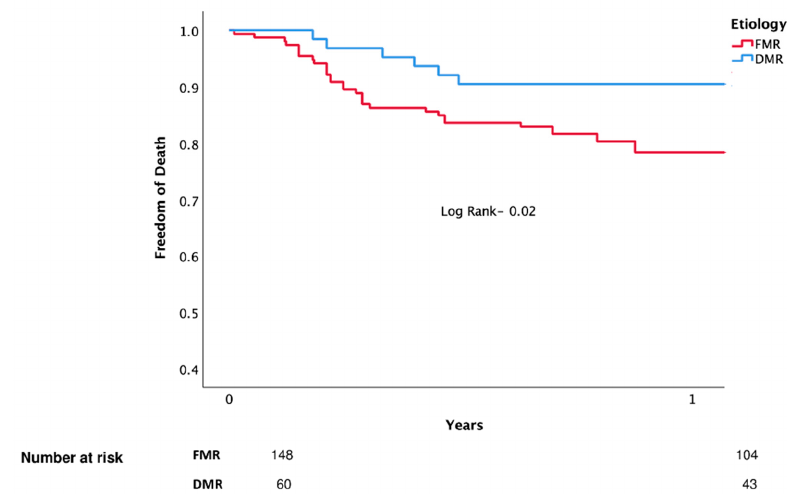
Figure 2. Death (unadjusted).